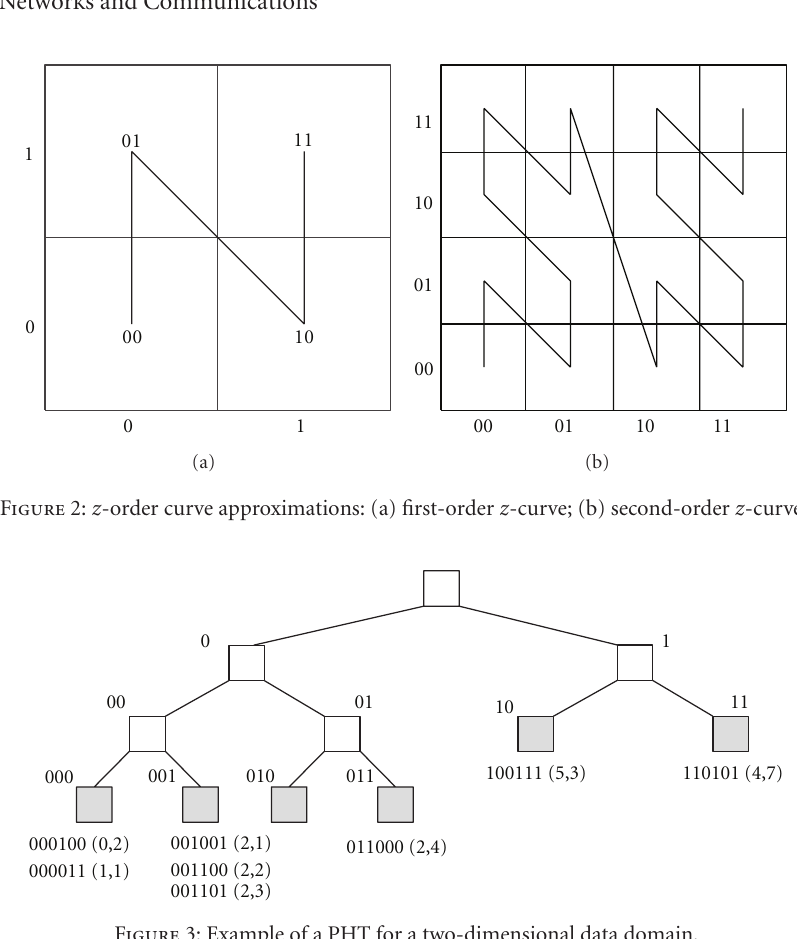
Figure 3: Example of a PHT for a two-dimensional data